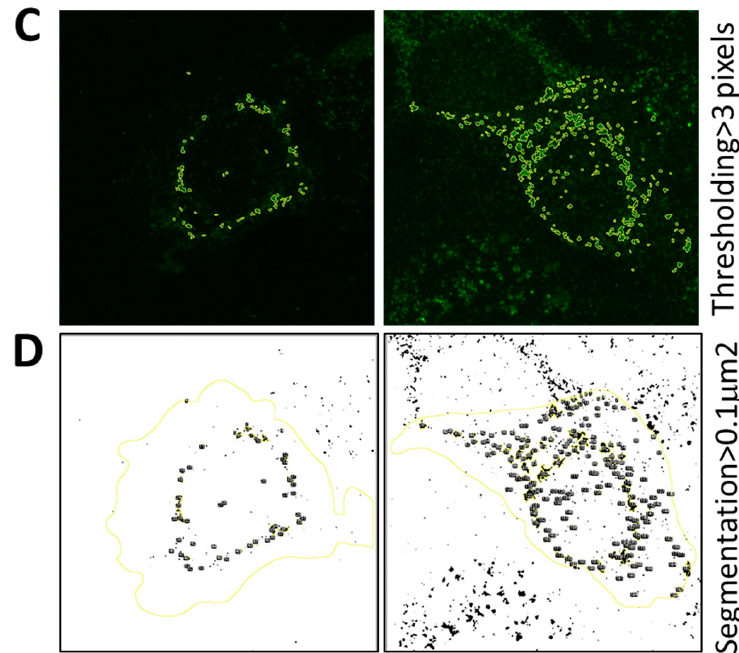
Figure A3. Macro used to quantify the surface area of mitochondrial citrate synthase spots. For mitochondrial surface measurement, a macro was developed in ImageJ software. Step 1: Segmentation delineating cell contours using wt and mut1 Noxo1-DDK immunolabeling ( A , red). Wt Noxo1 and mut1 Noxo1 cells counterstained with citrate synthase ( B , green). Scale bar in all panels: 10 µ m. Step 2: Cell thresholding keeping intensities greater than 3 pixels of citrate synthase labeling ( C , green). Step 3: Segmentation of citrate synthase spots displaying surface area greater than 0.1 µ m 2 ( D , yellow). The citrate synthase spots correspond to the mitochondrial surface. The Wilcoxon Mann-Whitney test was used to compare means and determine whether the differences observed in our experiments were significant or not to analyze whether there is a statistical difference between the mitochondrial surface area in wt Noxo1-DDK and mut1 Noxo1-DDK.